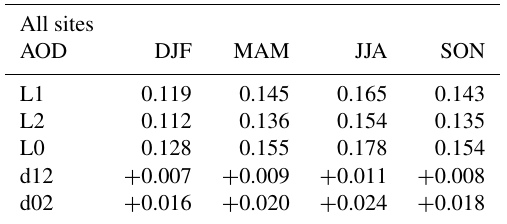
Table 2. Otherwise similar to Table 1, but showing overall results for all the